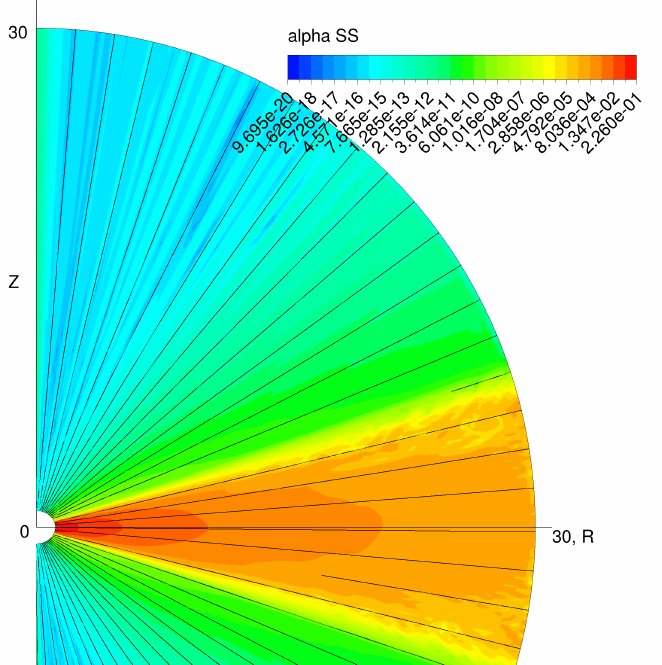
Figure 6. Logarithm of the Shakura–Sunyaev viscosity parameter α SS over the